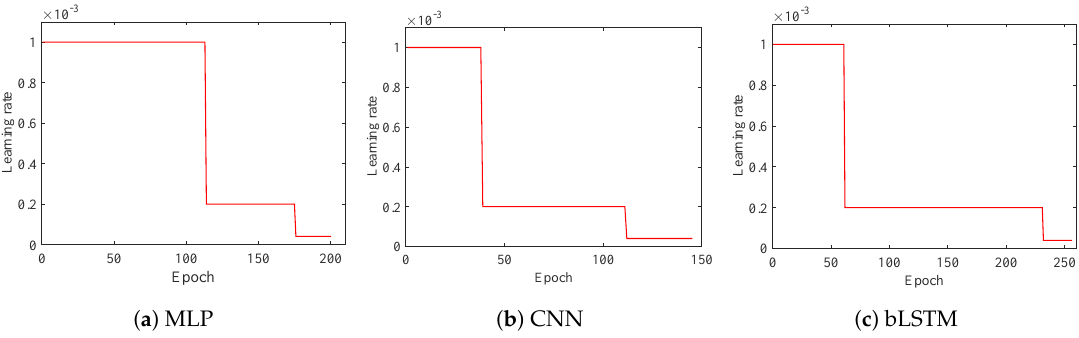
Figure 11. Learning rate of prediction in decoders.